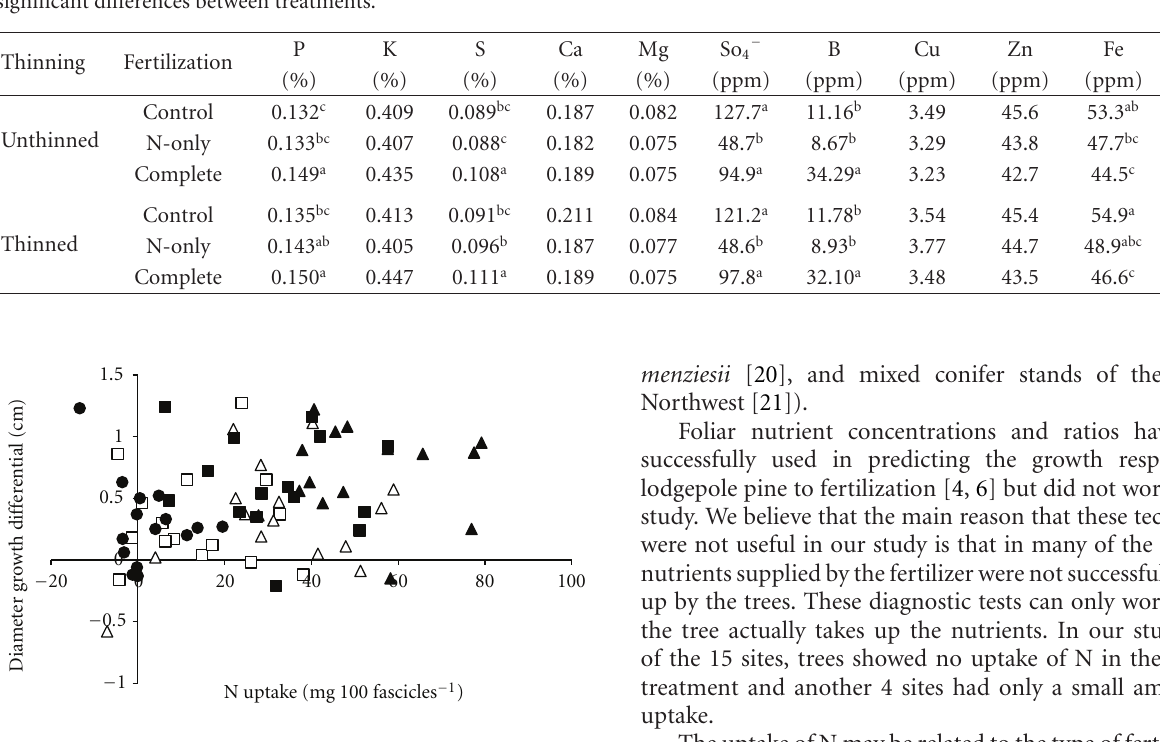
Table 3: Foliar nutrient concentrations after the first growing season in relation to thinning and fertilization treatments. Letters represent significant di ff erences between treatments.